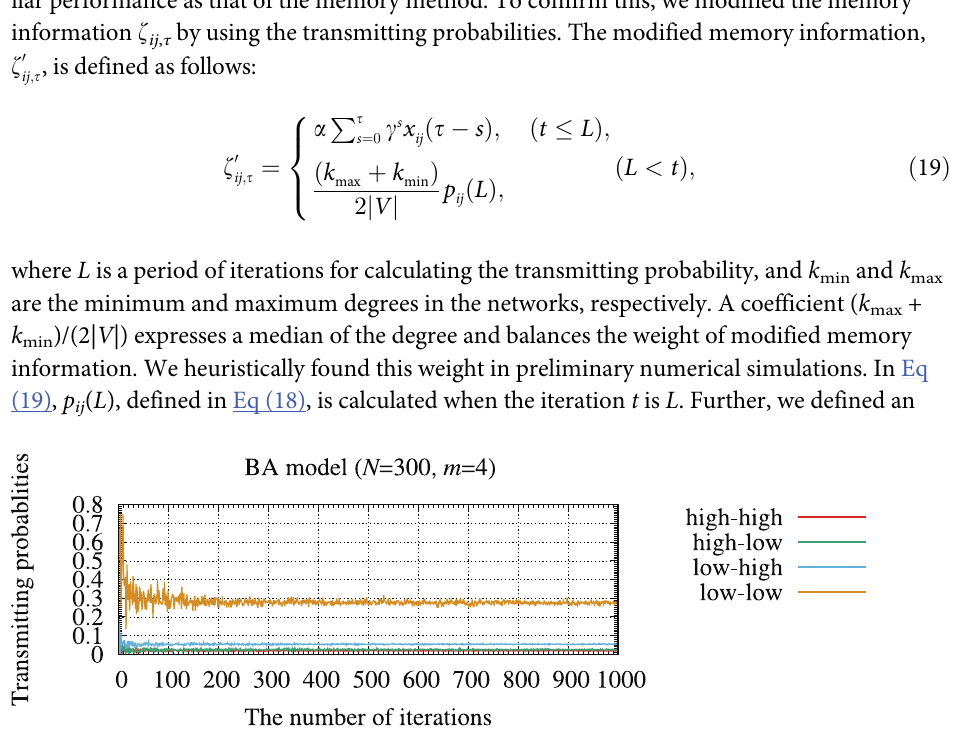
Fig 4. Typical examples of transmitting probabilities of four selected edges by the memory method for the BA model. In these simulations, we randomly selected four typical edges from different nodes in the networks. In this figure, “high-high,” “high-low,” “low-high,” and “low-low” are transmitting probabilities that connect high-degree nodes, high and low-degree nodes, low and high-degree nodes, and low-degree nodes, respectively.